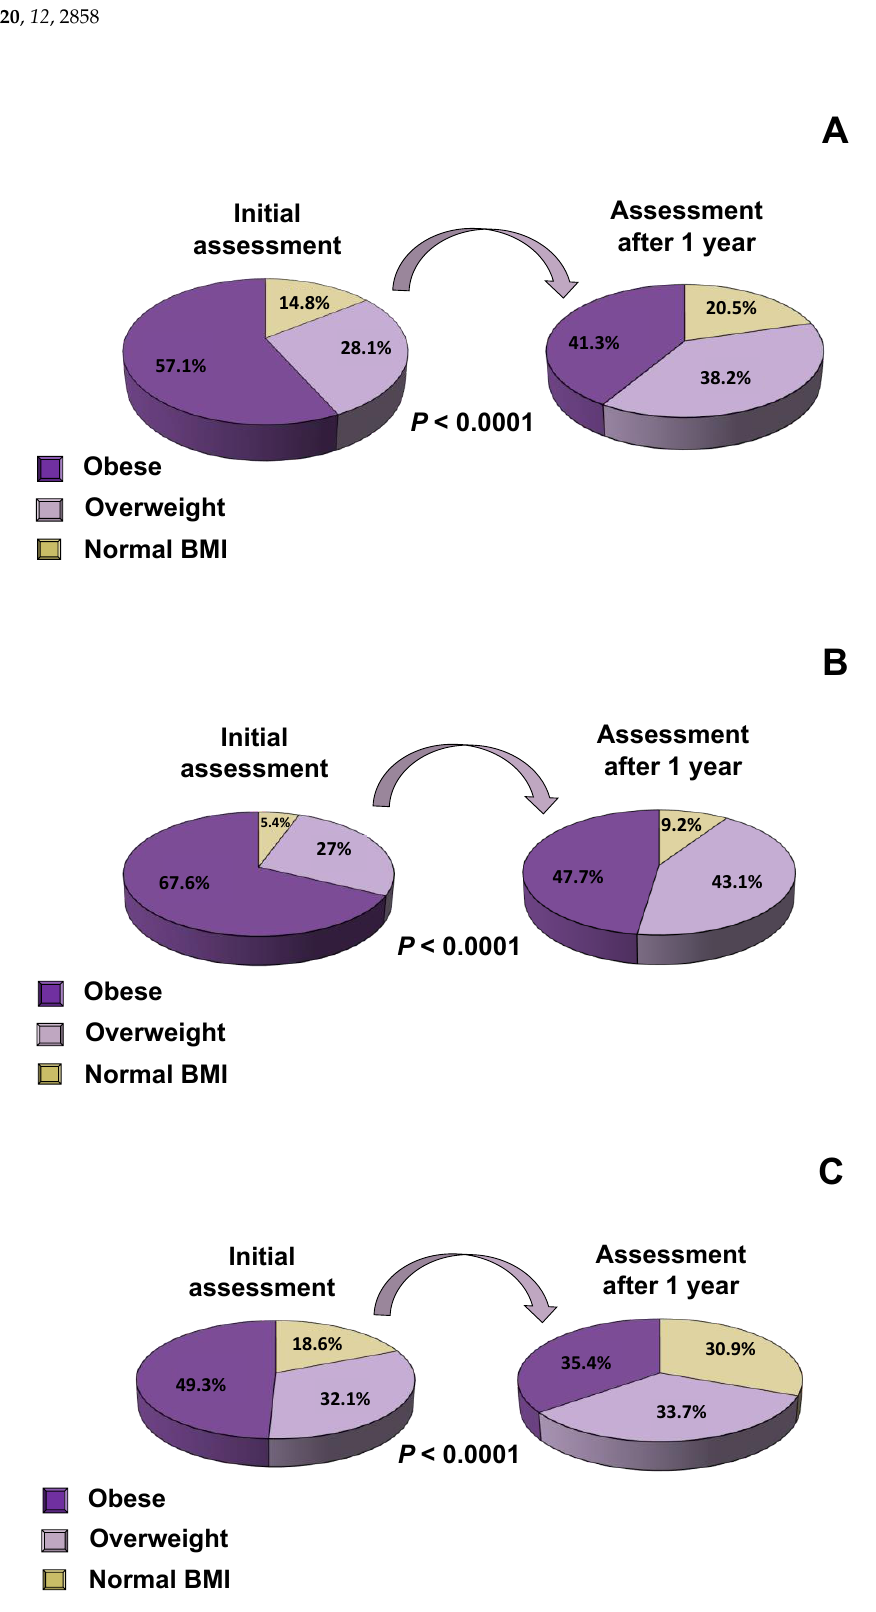
Figure 2. Alteration in BMI after 1 year of intervention: ( A ) in all subjects, ( B ) in boys, ( C ) in girls.